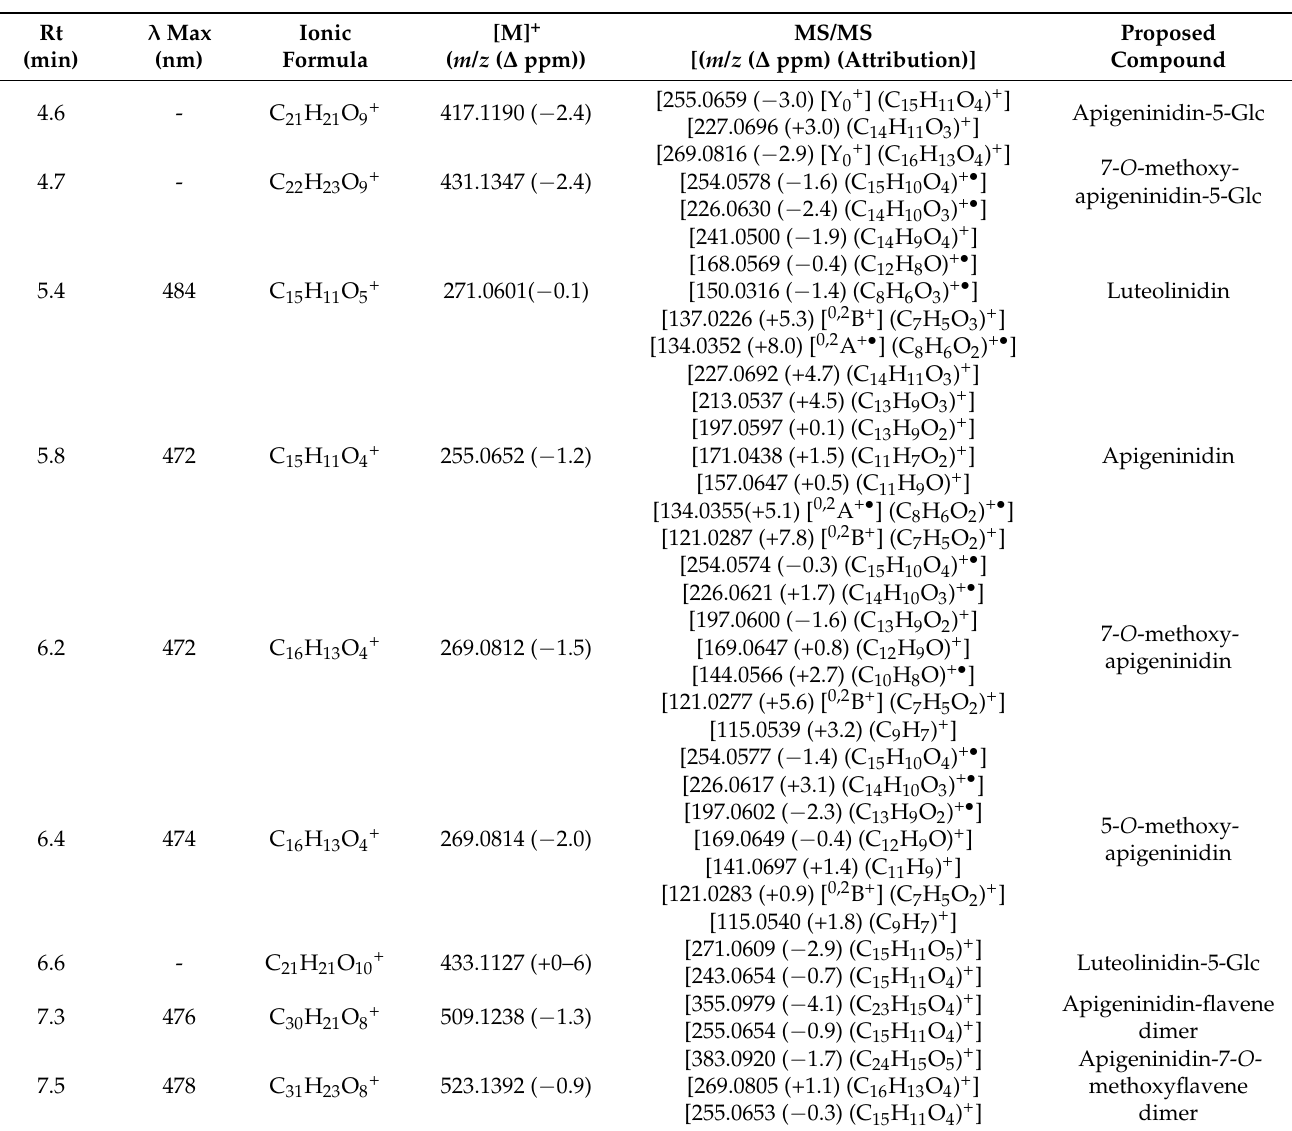
Table 1. HPLC-DAD and LC-ESI(+)-HRMS/MS characterisation of the main red